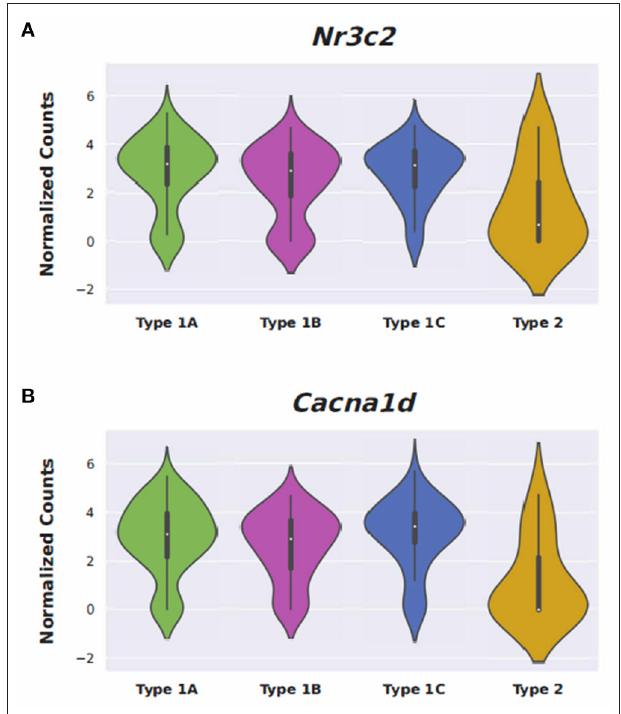
FIGURE 7 | Expression of Nimodipine drug targets, Nr3c2 and Cacna1d , in adult mouse spiral ganglion neurons (SGN). Expression of Nr3c2 (A) and Cacna1d (B) in an adult mouse spiral ganglion neuron (SGN) single-cell RNA-Seq dataset (18). Expression is displayed as normalized counts along the vertical axis and SGN subtypes (Type 1A, 1B, 1C, and Type 2) are displayed along the horizontal